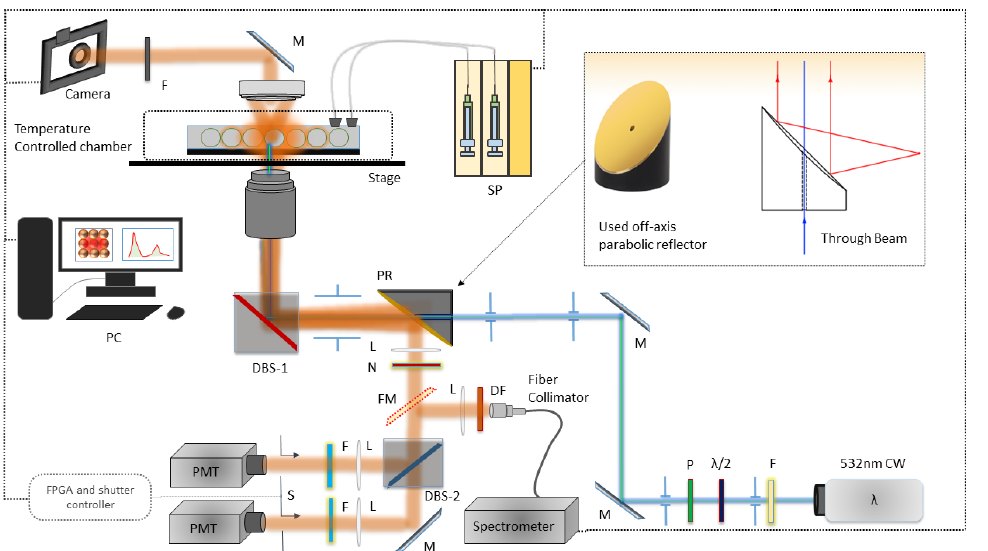
Figure 1. Reflection mode-dual channel microfluidic droplet monitoring setup, consisting of a continuous wave (CW) 532 nm laser source. Laser is band limited by a bandpass filter followed by a half-wave plate and a polarizer. After couple of mirrors (M) and iris diaphragms, laser is coupled from rear end of the off-axis reflector (inset: used Thorlabs Off-Axis parabolic mirror with a hole parallel to collimated laser beam). Later, laser is reflected by DBS-1 (735 nm Brightline multiphoton single-edge dichroic beamsplitter: FF735-Di02-25x36), coupled into the microscope objective, and hits the sample. The fluorescent signal is coupled back to the objective, then hits the 735 nm edge filter, and gets reflected from the parabolic mirror. A laser notch filter (N) is placed inline to cut off any stray laser component present in the reflected signal. Another dichroic beamsplitter, DBS-2 (532 nm Brightline single-edge laser dichroic beamsplitter: Di02-R532-25x36), splits the fluorescent signal into two bands, one below 540 nm and one above 540 nm. The two components of the fluorescence signals emitted by the dye are separated, filtered, and collected on two different photo-multiplier tubes (PMT). For spectral investigations, a flipping mirror (FM), a lens (L), a density filter (DF), and an air-spaced fiber collimator was used to couple the signal to the